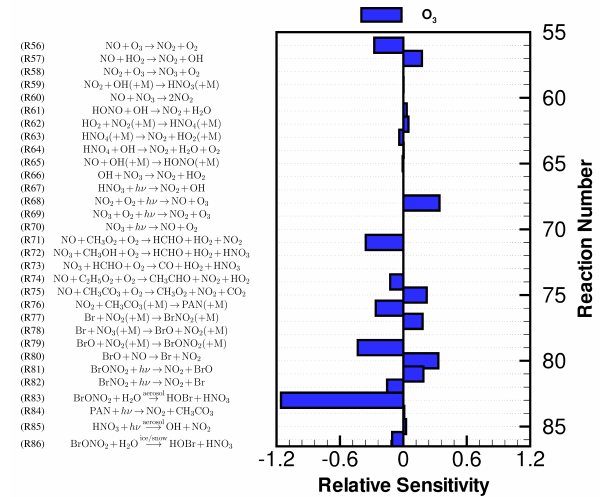
Fig. 12. Instantaneous relative sensitivities of O 3 concentrations at day 4 for a boundary layer height of 200m.